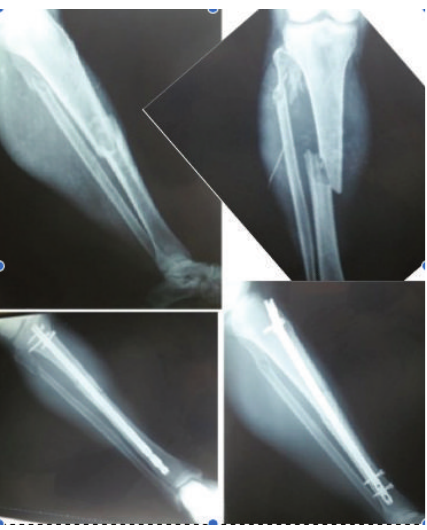
Figure 1: Anteroposterior and lateral X-ray images showing a middle one-third tibial shaft fracture with an associated fibular fracture and a healed tibial fracture treated with intramedullary nailing.